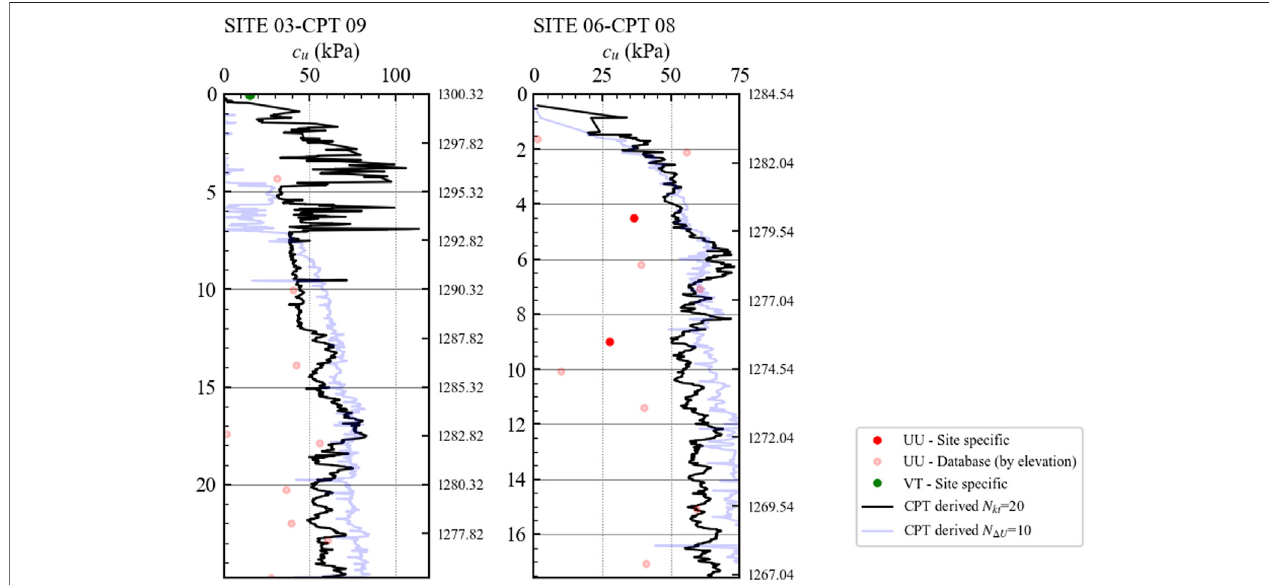
FIGURE 11 | Derivation of undrained shear strength using an N kt (cid:1) 20 and N Δ u (cid:1) 10, comparison against both site-speci fi c unconsolidated undrained triaxial (UU) and database UU tests in silts displayed by elevation.